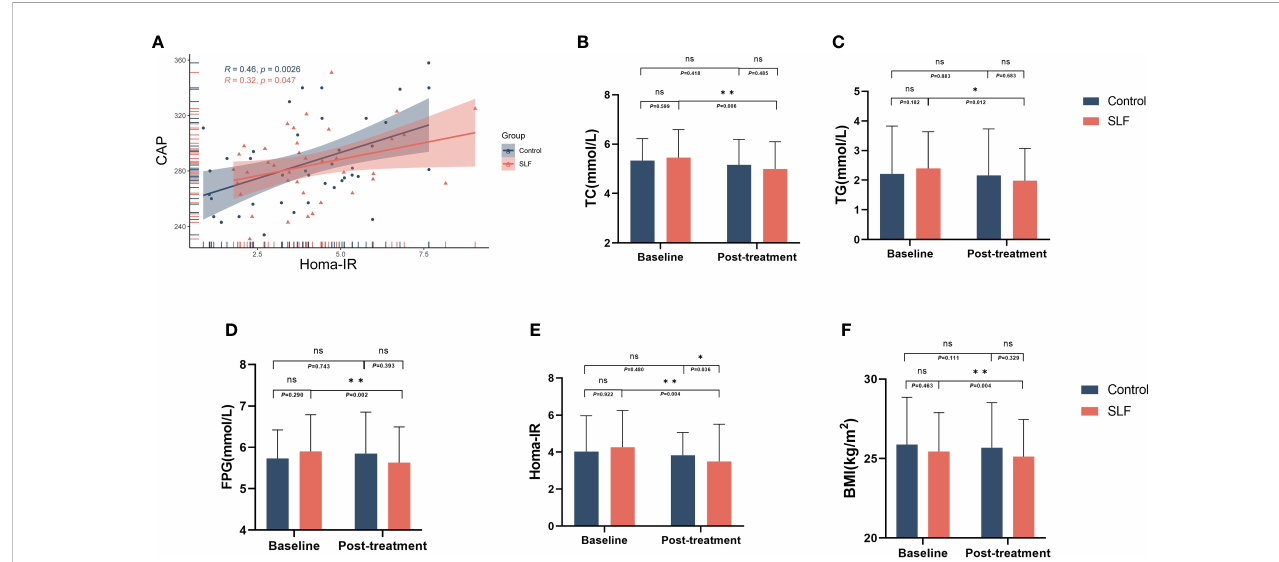
FIGURE 3 SLF could improve glycolipid metabolism. TC, TG, FPG, HOMA-IR, and BMI were compared to evaluate the ef fi cacy of SLF on metabolism, especially glycolipid metabolism. (A) Correlation of HOMA-IR and CAP. (B) Comparison of TC in the control group and SLF group. (C) Comparison of TG in the control group and SLF group. (D) Comparison of FPG in the control group and SLF group. (E) Comparison of HOMA-IR in the control group and SLF group. (F) Comparison of BMI in the control group and SLF group. TC, Total cholesterol; TG, Triglyceride; FPG, Fasting blood glucose; HOMA-IR, Homeostasis model assessment of insulin resistance; BMI, Body mass index. ns, no signi fi cance. * P < 0.05 and ** P <